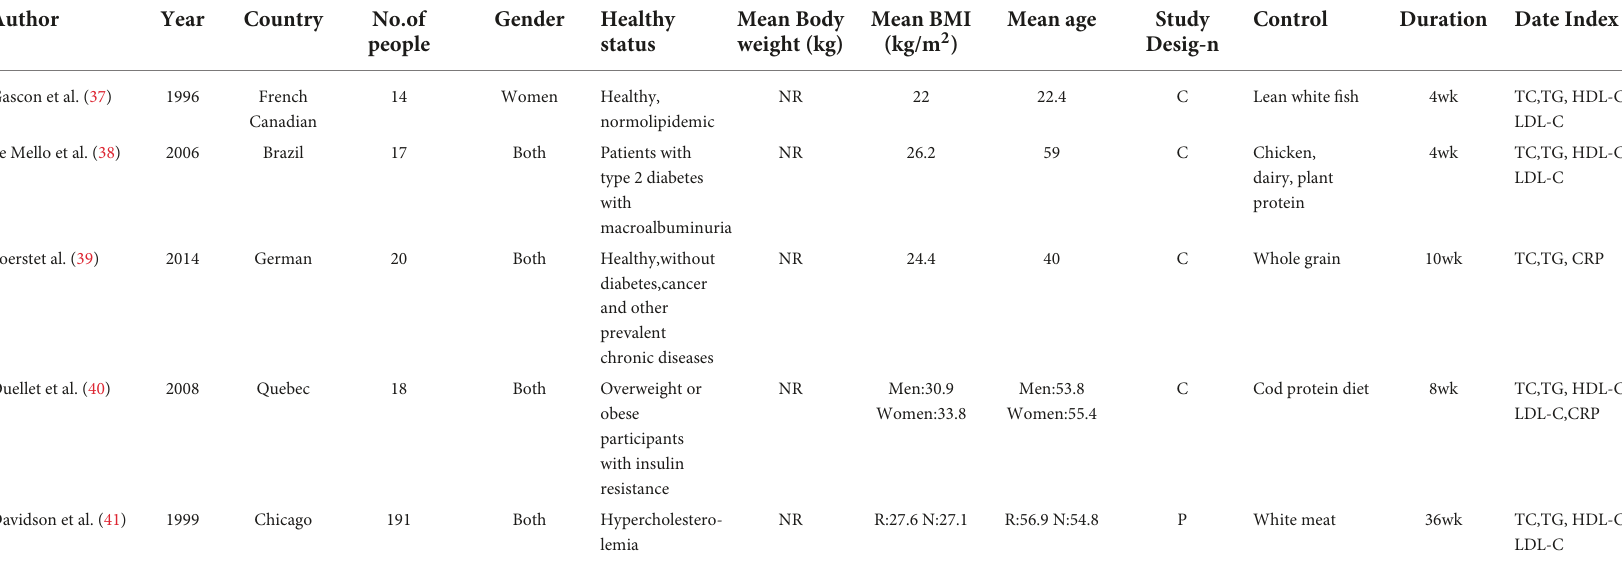
TABLE 3 Characteristics of the 20 RCT studies